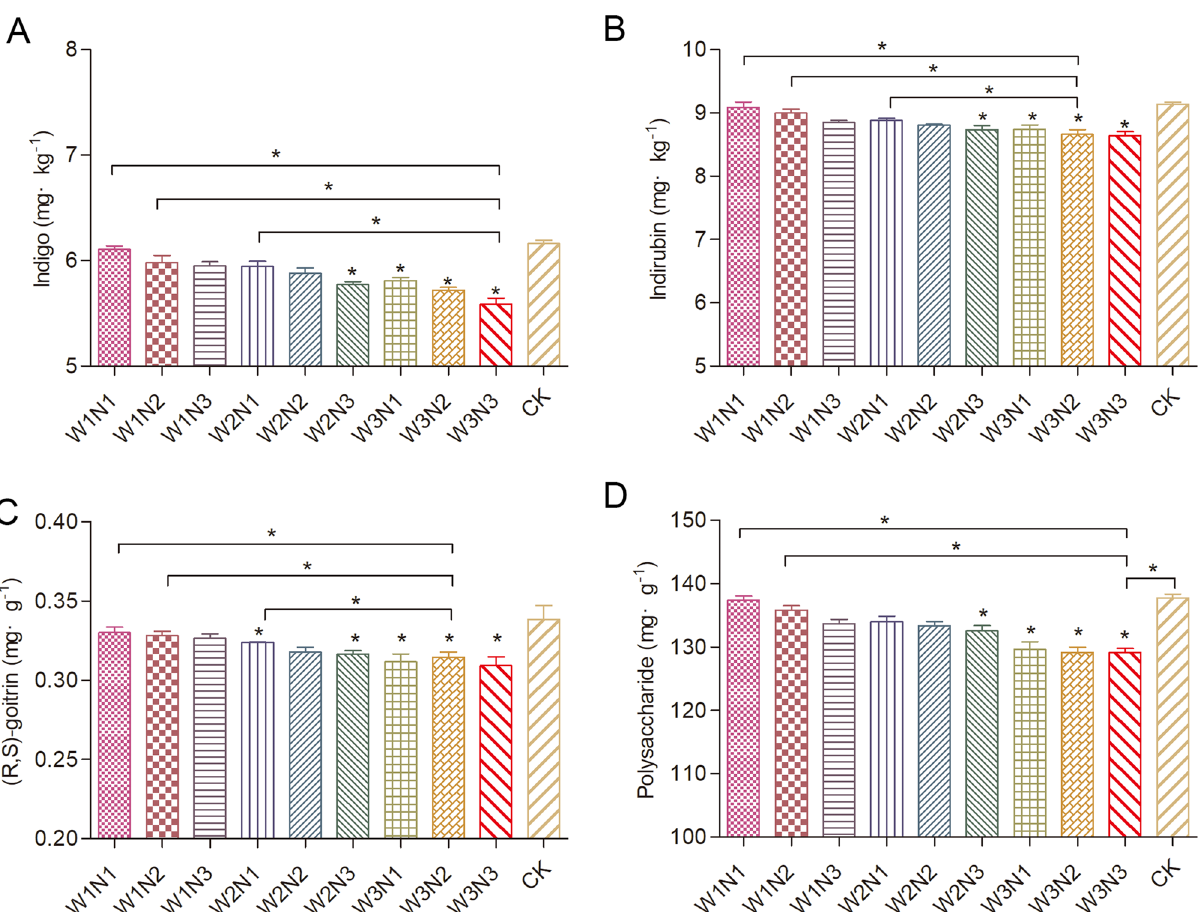
Figure 3. Quality values for Isatis indigotica in all treatments. The values shown are the mean ± SD, n = 3. Asterisks (*) indicate a significant difference at the P ≤ 0.05